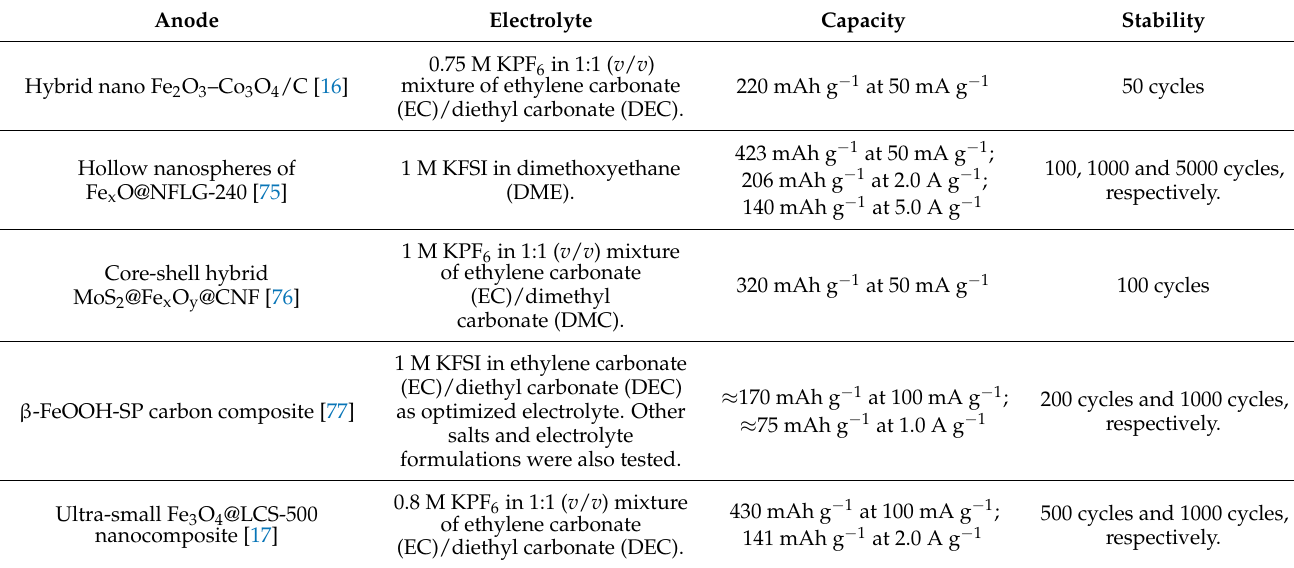
Table 4. Synoptic comparison of the electrochemical performances obtained in K-ion cells for various types of hybrid nanostructures based iron oxides and carbon materials. These active nanomaterials were tested as potential anodes for KIBs and typically cycled between 0.01 and 3.0 V vs. K + /K. Anode Electrolyte Capacity